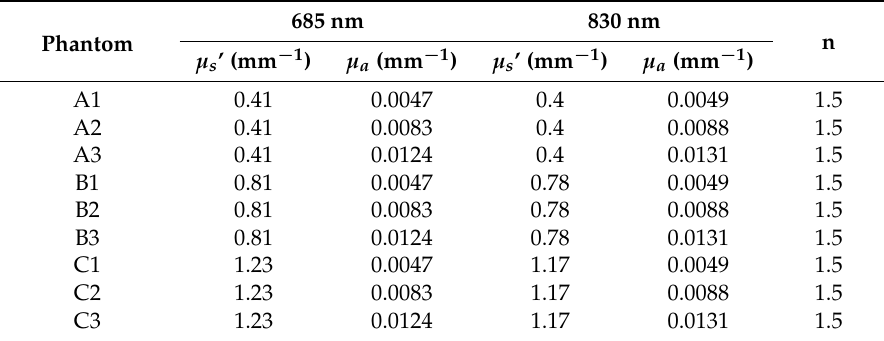
Table 1. The nominal OP of the measured phantoms in this